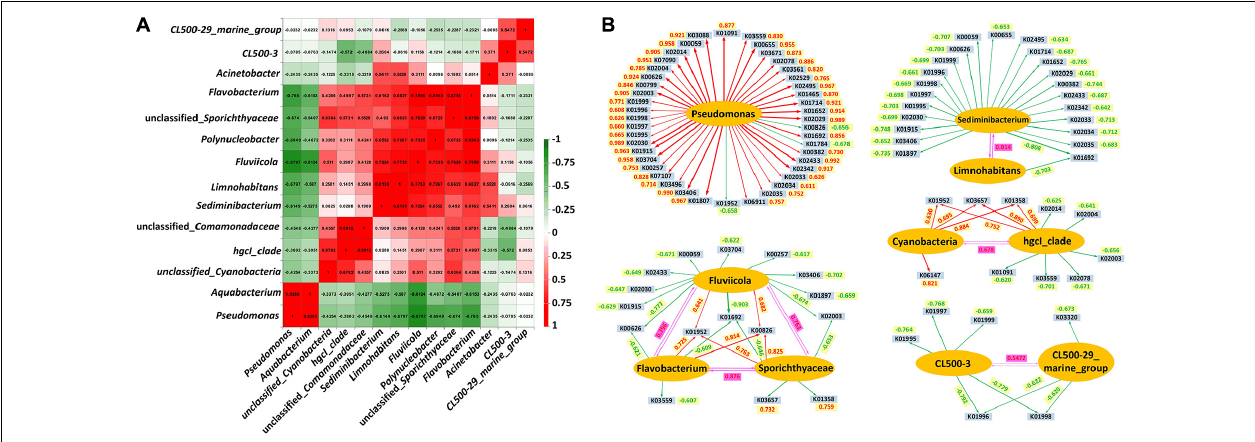
FIGURE 5 | Co-occurrence network analysis of the bacterial communities at different depths in the two reservoirs. (A) Analysis of co-occurrence network among different dominant genera. Only the genera that have relative abundances > 0.5% are shown. (B) Pearson correlations between the KEGG orthologous (KO) gene families (top 50 KOs) and bacterial relative abundances. Only the genera that have relative abundances > 0.5% are shown. Bacterial genera are presented in ellipses with orange background. KOs are depicted in rectangles with light blue background. The correlation between different genera are indicated by a purple background. Positive and negative associations are indicated by red and green arrow lines respectively. Red and green values represented the correlation coefficients of positive and negative associations,